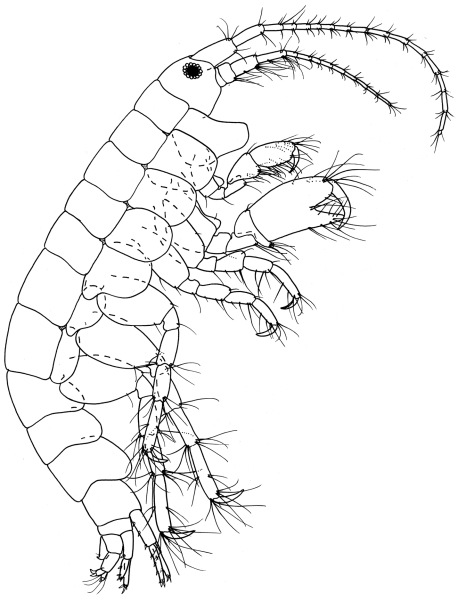

Plumithoe latasp. n., male